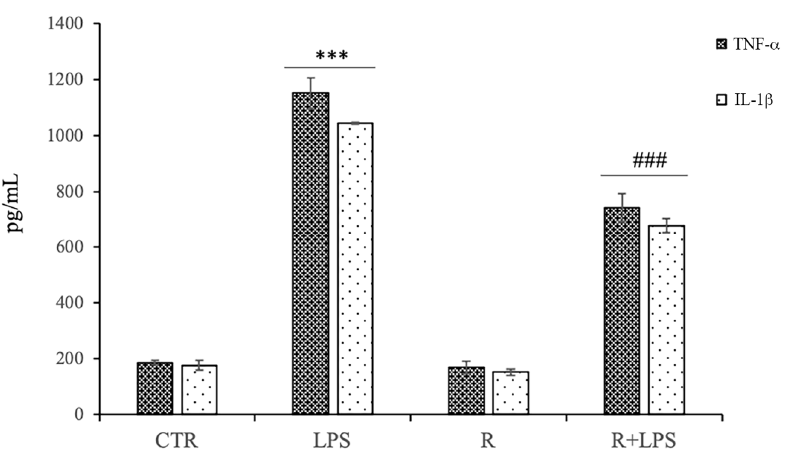
Figure 4. Effects of resveratrol (R) on the pro-inflammatory cytokines release in N13 microglial cells treated with LPS for 72 h. The concentrations of TNF- α and IL-1 β measured in supernatants were detected by ELISA and expressed as pg/mL. N13 cells were incubated with medium alone (CTR), LPS (100 ng/mL), resveratrol (10 µ M) (R), or resveratrol and LPS (R + LPS). Data are expressed as means ± SD of five independent experiments. *** p < 0.001 LPS vs. control; ### p < 0.001 R + LPS vs.